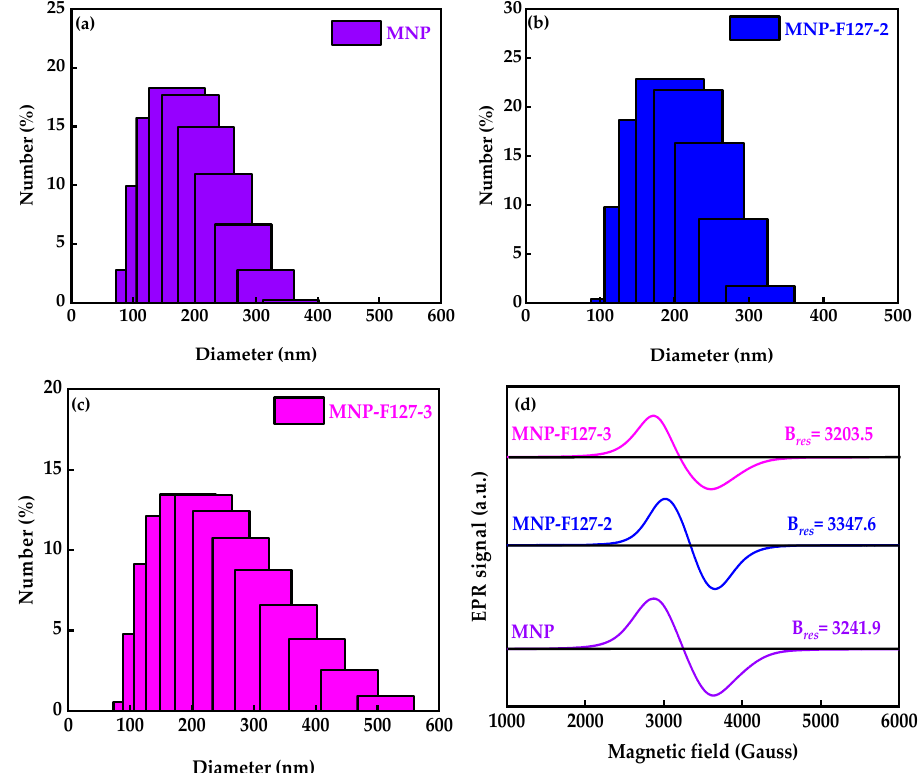
Figure 1. ( a – c ) Dynamic light scattering particle size distribution and ( d ) electron paramagnetic resonance of MNP, MNP-F127-2, and MNP-F127-3 nanocomposites. The XRD patterns were conducted to investigate the structural parameters of the as- synthesized MNP, MNP-F127-2, and MNP-F127-3 smart nanocomposites. The XRD pat-